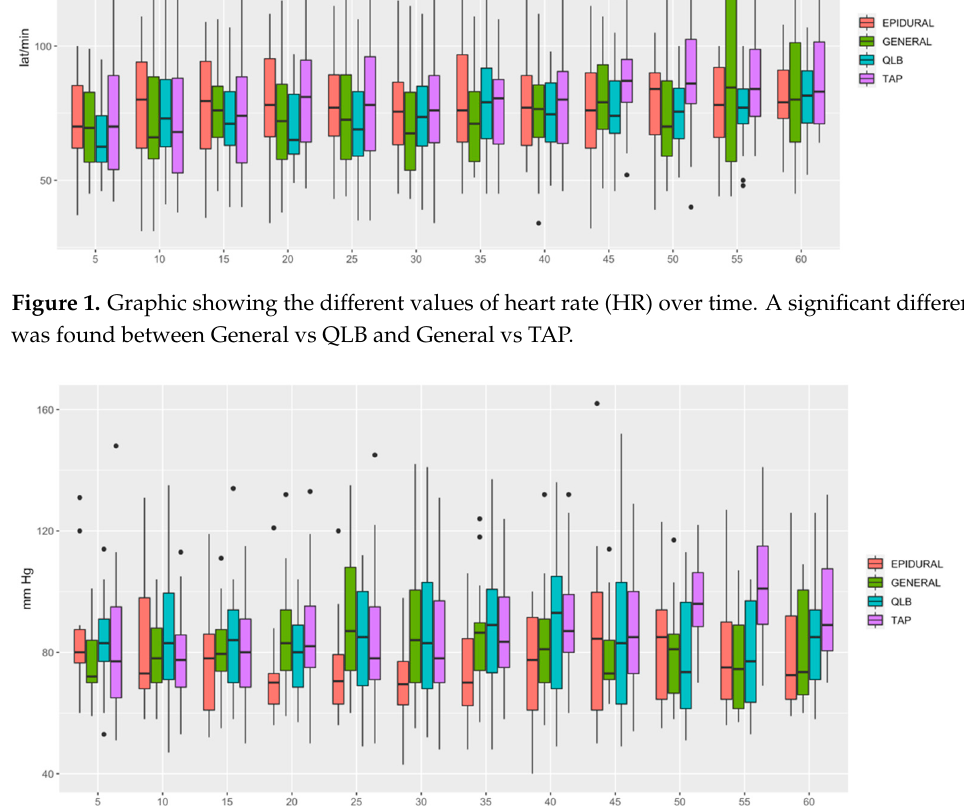
Figure 3. Graphic showing the different values of systolic arterial pressure (SAP) over time.